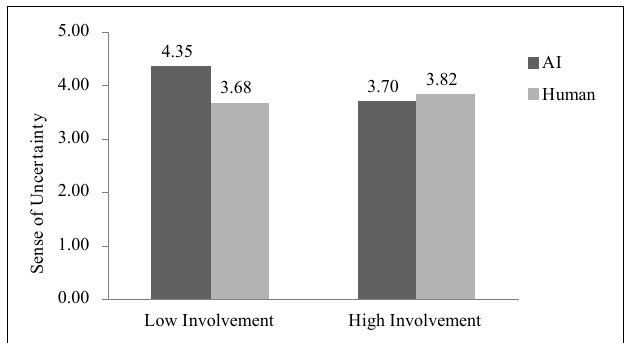
FIGURE 4 | Interaction effect on the sense of uncertainty in study